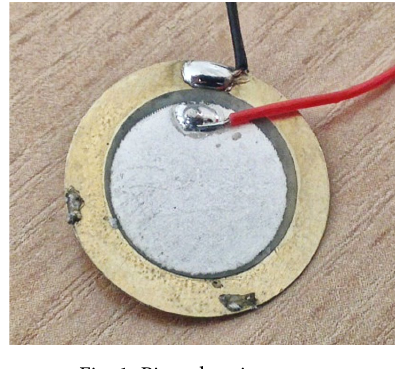
Fig. 1. Piezoelectric sensors